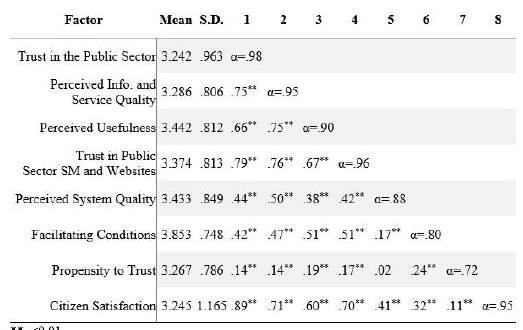
Table 2: Factor Correlations, Cronbach’s Alphas, Means and Standard Deviations